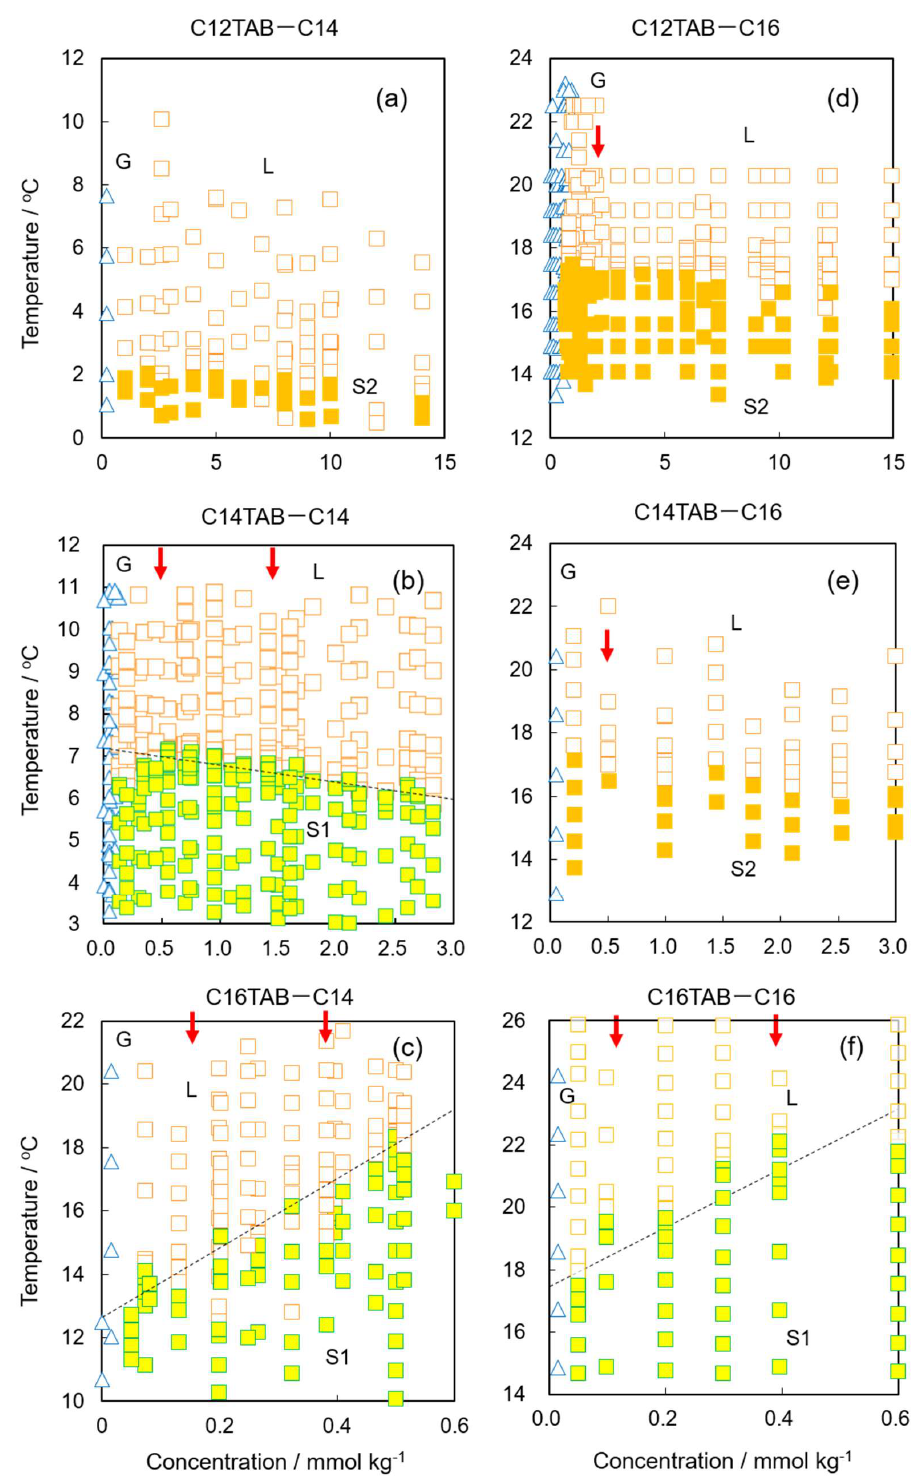
Figure 2. Surface phase diagrams for ( a ) C12TAB + C14, ( b ) C14TAB + C14, ( c ) C16TAB + C14, ( d ) C12TAB + C16, ( e ) C14TAB + C16, and ( f ) C16TAB + C16 systems. Blue open triangles and orange open squares are the G and L states, respectively. Orange and yellow filled squares are the S2 and S1 states, respectively. Red arrows in each diagram show experimental conditions where Brewster angle microscopy was applied.